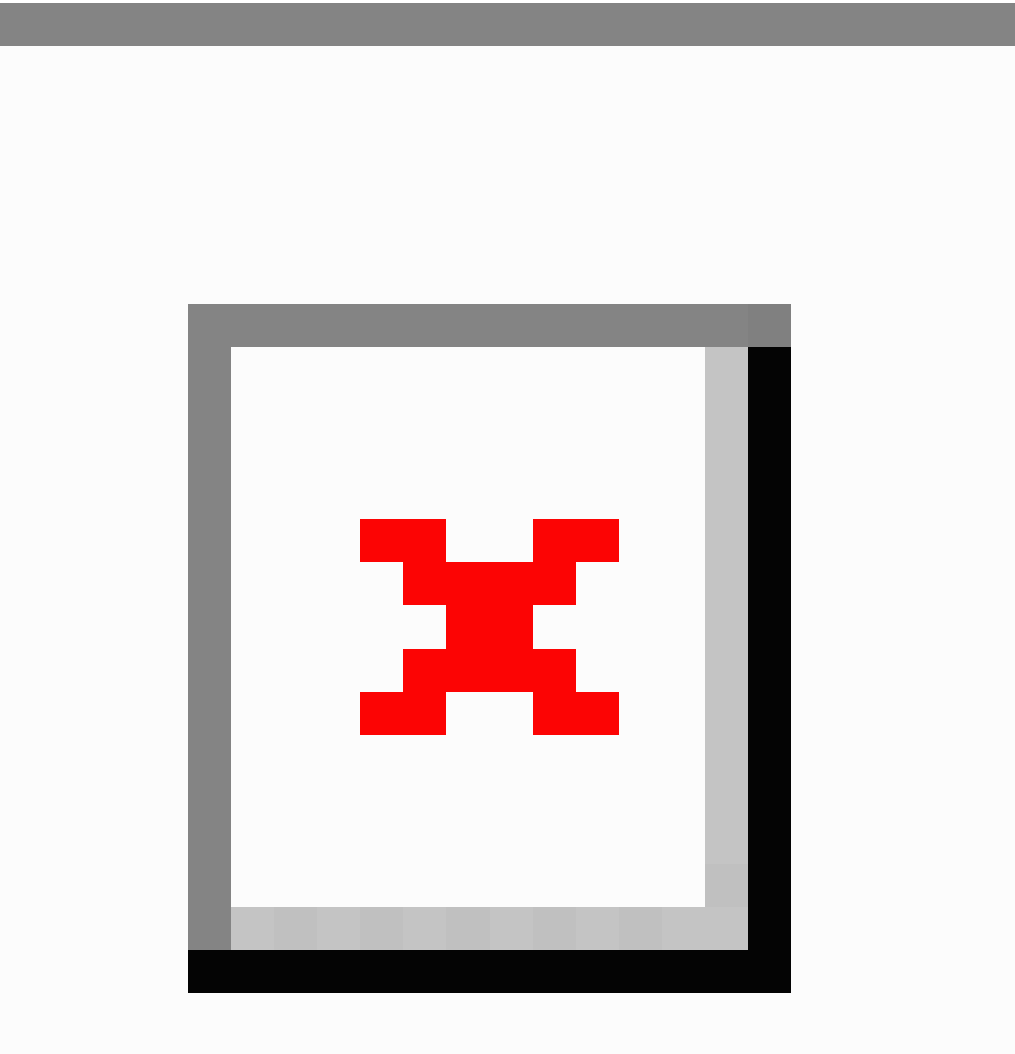
Figure 4. Serial changes in the number of newspaper articles containing positive, negative, and neutral keywords related to cervical cancer and the names of relevant Japanese